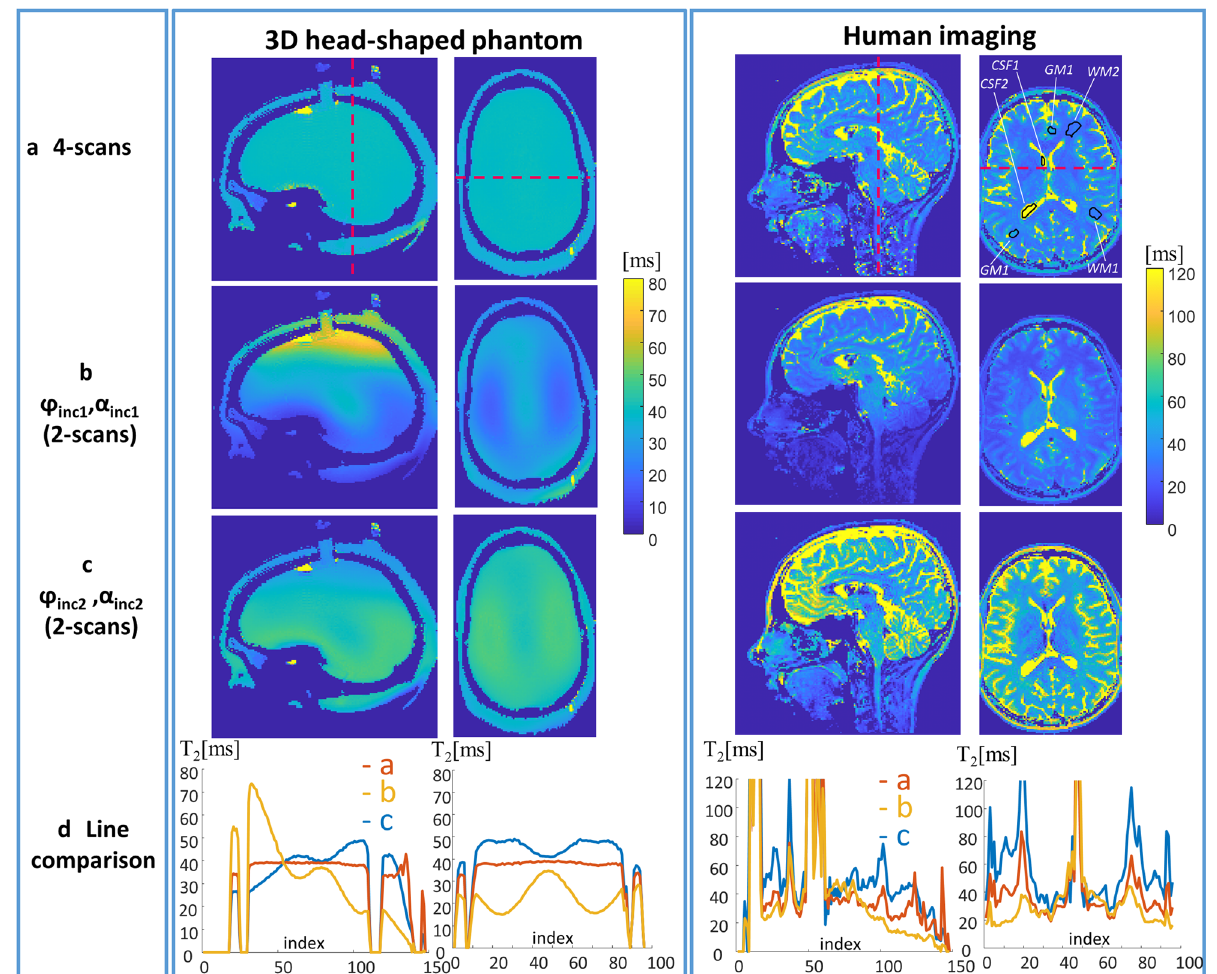
Figure 4. Comparison of T 2 maps extracted with ( a ) 4-scans, ( b ) single pair with (φ inc1, α scan1 ) and ( c ) single pair with (φ inc2, α scan2 ). ( d ) For each case a plot for a line shown in the Sagittal and Axial scans. The images show 3D-head shaped phantom (left) and human imaging (right). The human axial plane image in ( a ) shows the regions that were examined and summarized in Table 1.